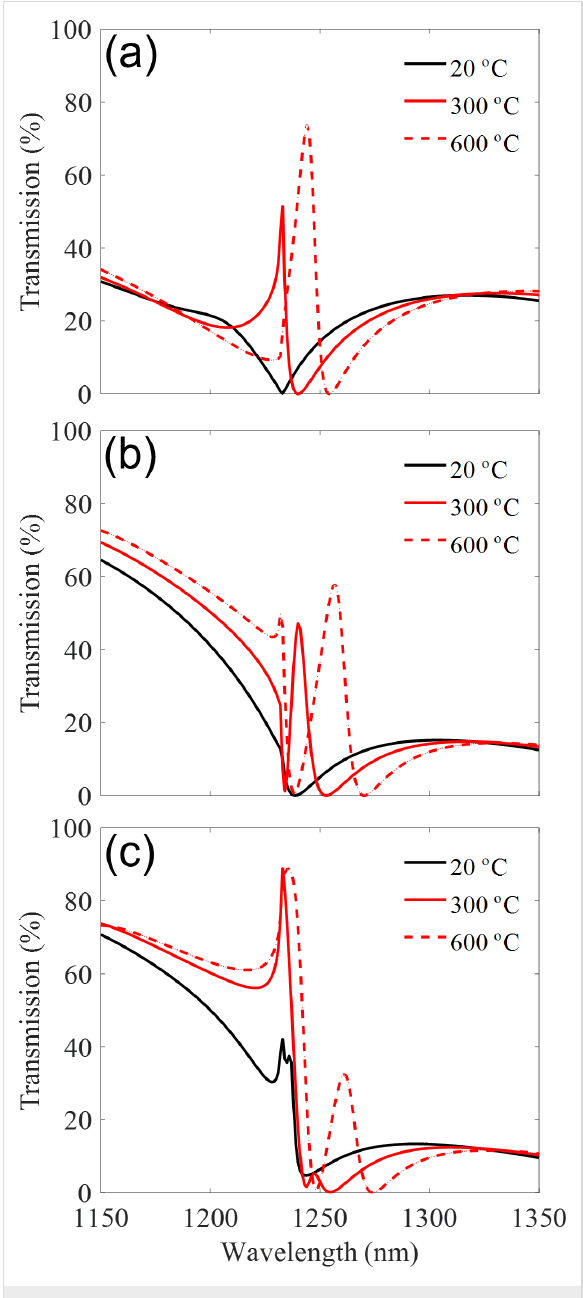
Figure 5: The transmission spectrum for three different SiO 2 thick- nesses (a) t = 150 nm, (b) t = 250 nm and (c) t = 300 nm.